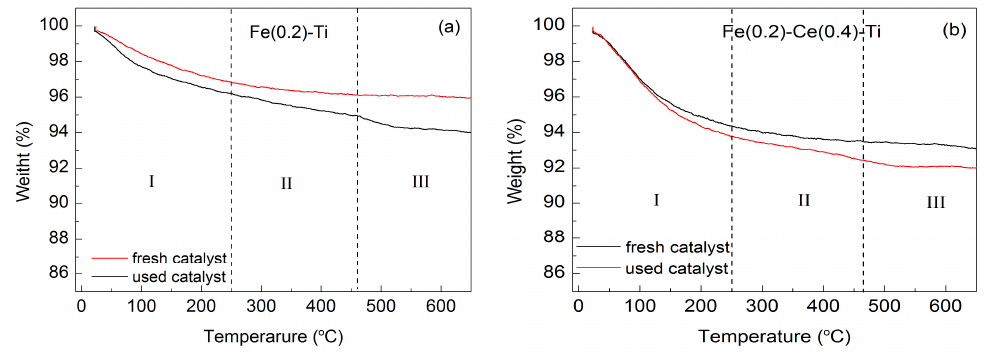
Figure 11. Thermogravimetric analysis (TGA) spectra of the fresh and used catalyst ( a ) Fe(0.2)–Ti and ( b ) Fe(0.2)–Ce(0.4)–Ti.